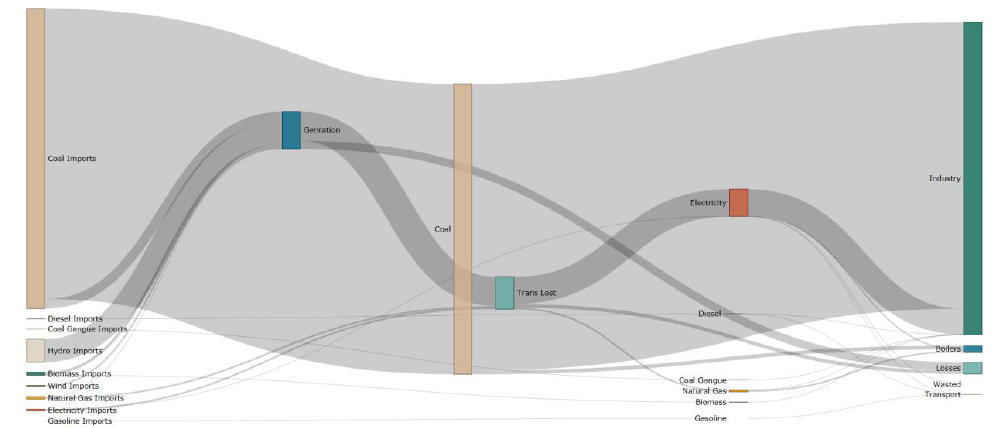
Figure 4. The Sankey Diagram of the Panzhihua LEAP model (this figure was constructed for this study). Table 3. Panzhihua LEAP model energy balance sheet (base year).